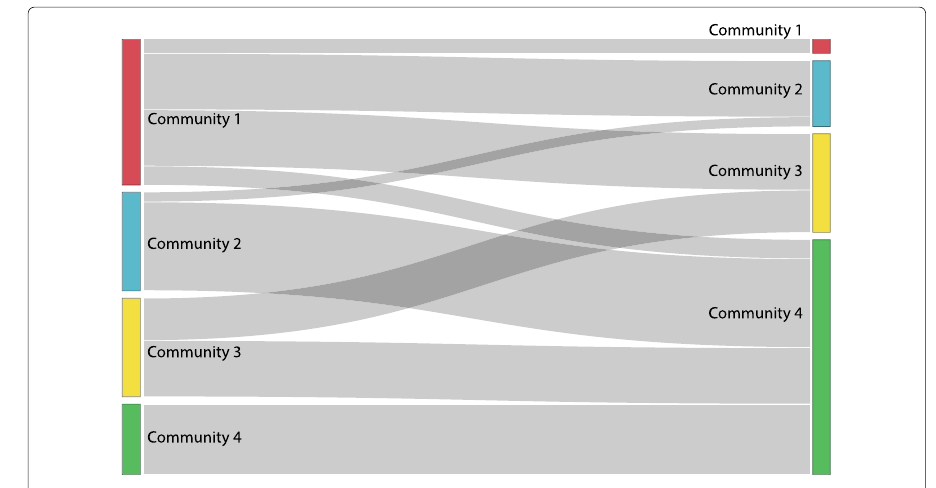
Fig. 5 Comparison between the partitions obtained via community detection based on the land-use network and on the mobile-phone network. The Sankey diagram reveals differences and overlaps between the partitions in communities obtained analyzing land uses (left side) and mobile phone data (right side). Color coding is coherent with partitioning shown in Figs. 3 and